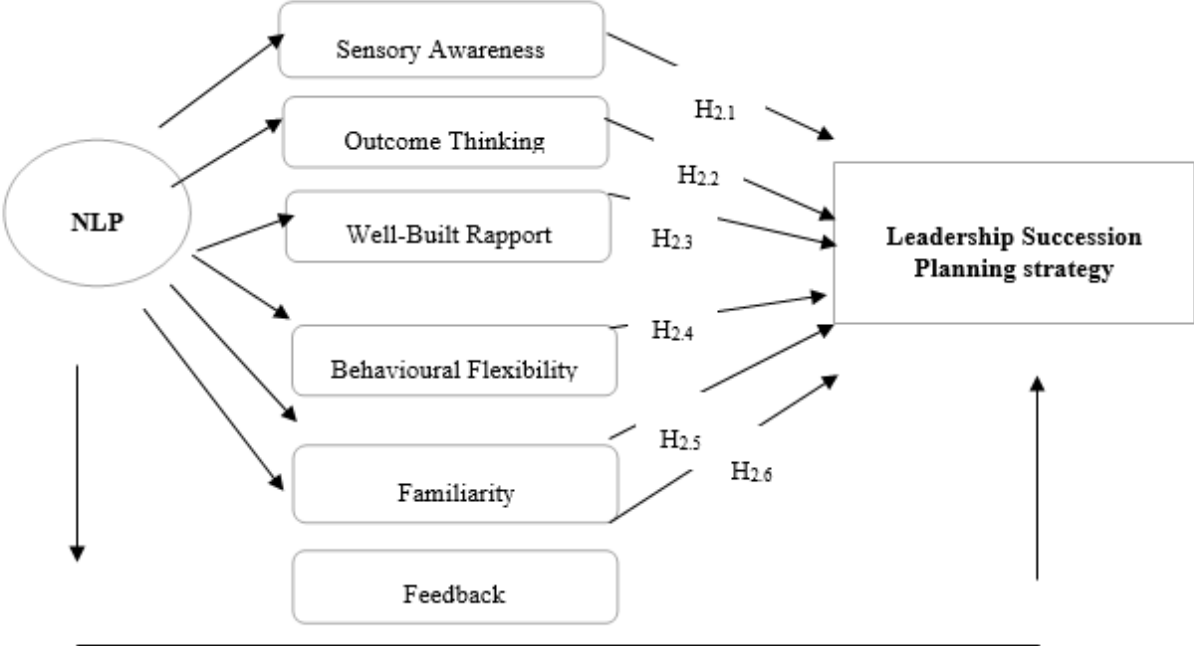
Figure 6. The Proposed Hypothetical Model for the